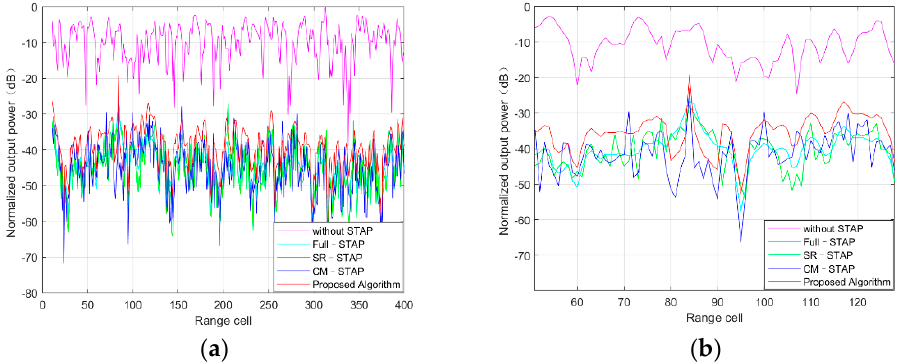
Figure 7. Performance of distance dimension in ( a ) the 0–400th range bin and ( b ) the 60–120th range bin